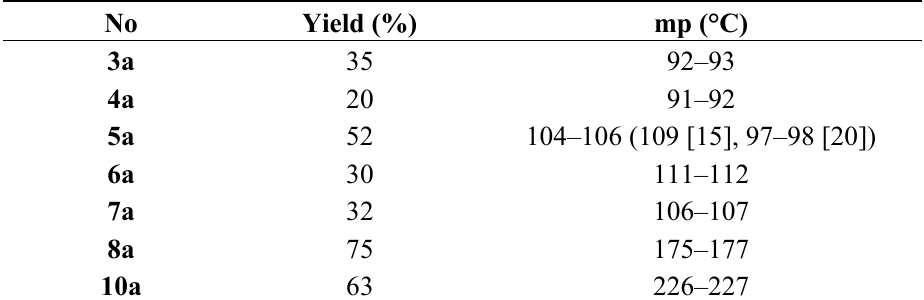
Table 1. Reaction yields and melting points of compounds 3a – 8a and 10a .